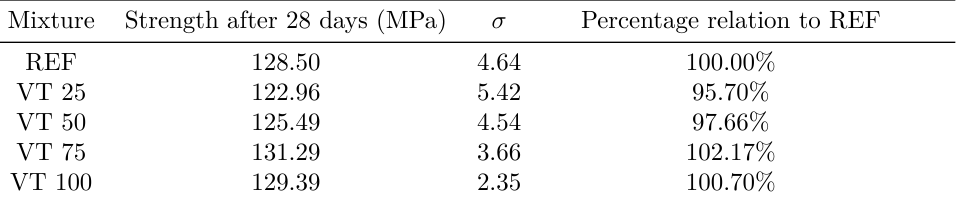
Table 4. Compressive strength (fragments of blocks 40